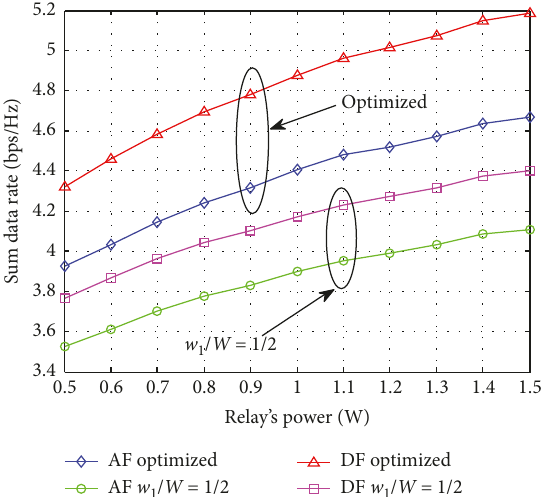
Figure 5: Sum data rate vs. the relay’s power P ( d � 2packets / s, and R λ e